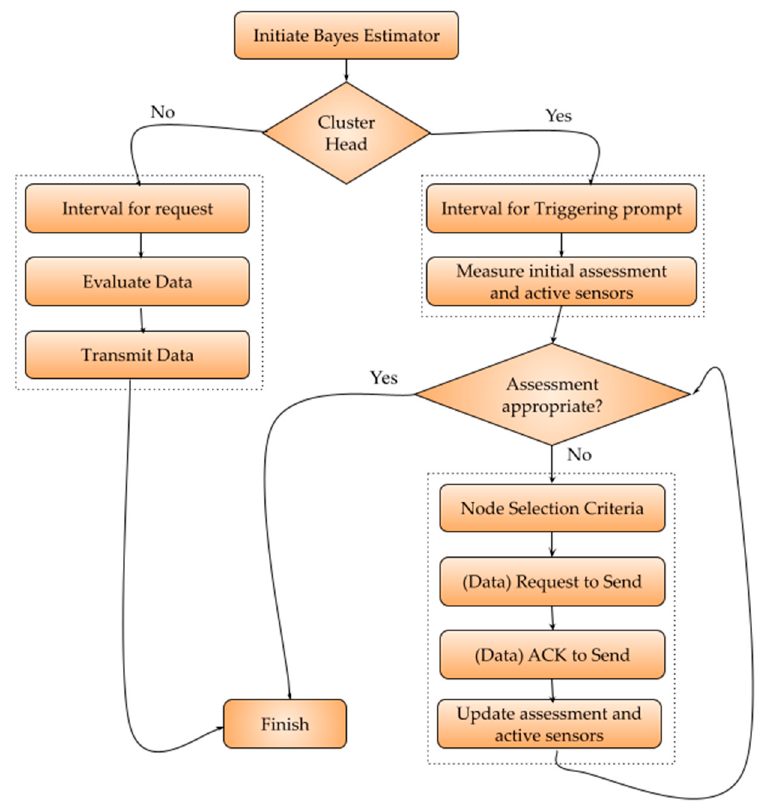
Figure 3. Flow diagram for data retrieval and evaluation from sensing nodes.